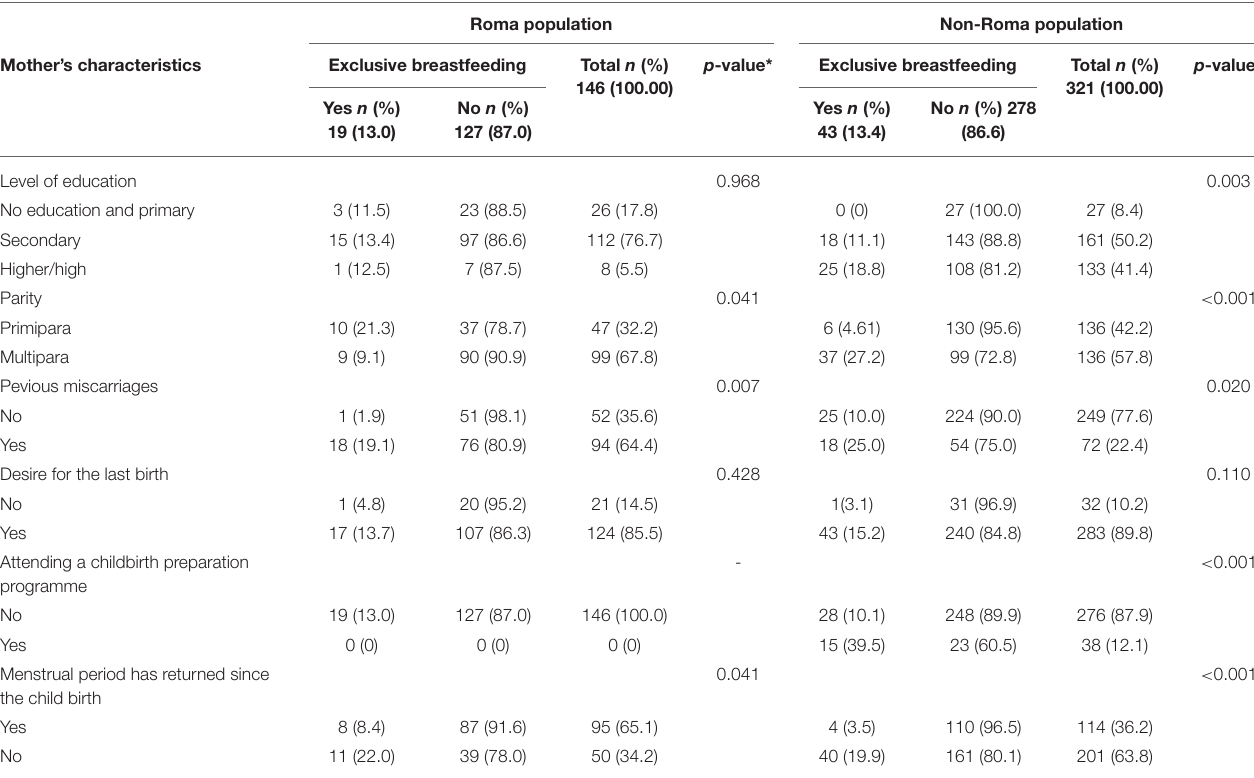
TABLE 3 | Mother’s characteristics and practice of exclusive breastfeeding under the age of 6 months.